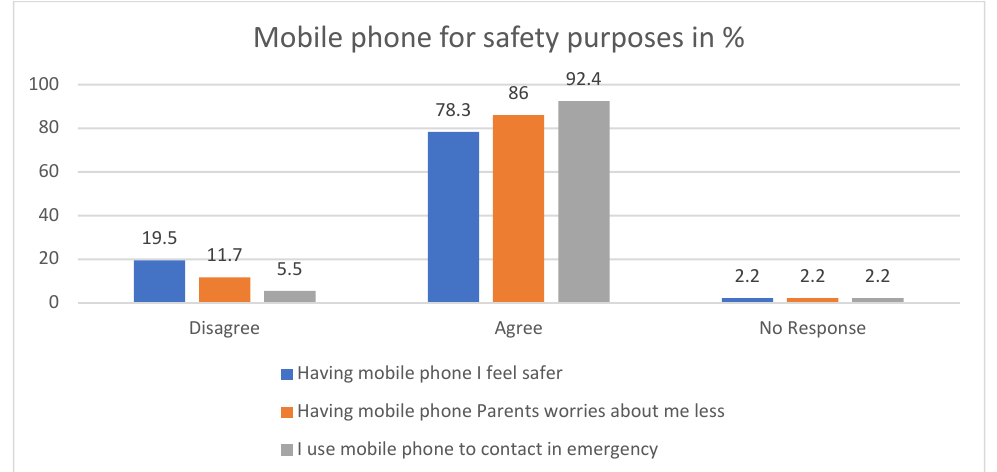
Figure 6. Use of mobile for safety purpose by young People. Table 6. T -test of using mobile phone safety purposes.